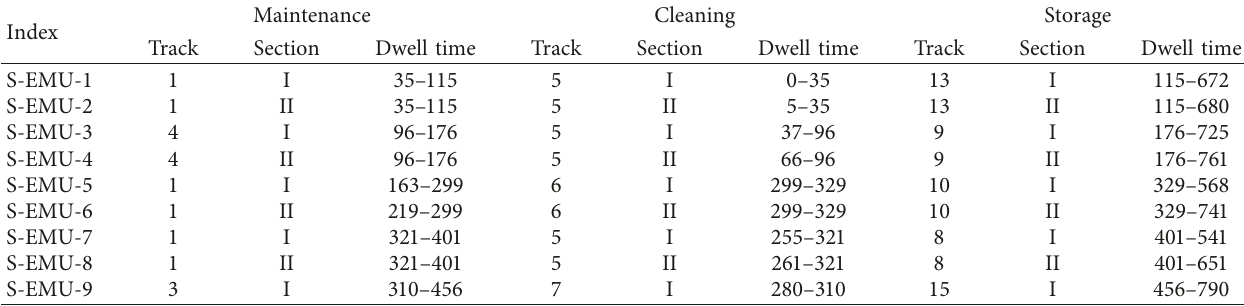
Table 8: The shunting operation plan of S-EMUs at a through EMU depot generated by the RVNS algorithm.